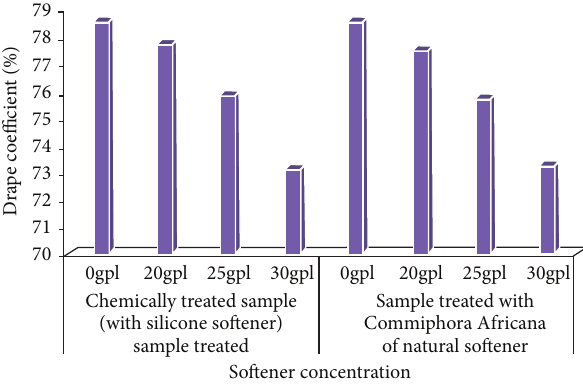
Figure 3: Effect of softener on fabric